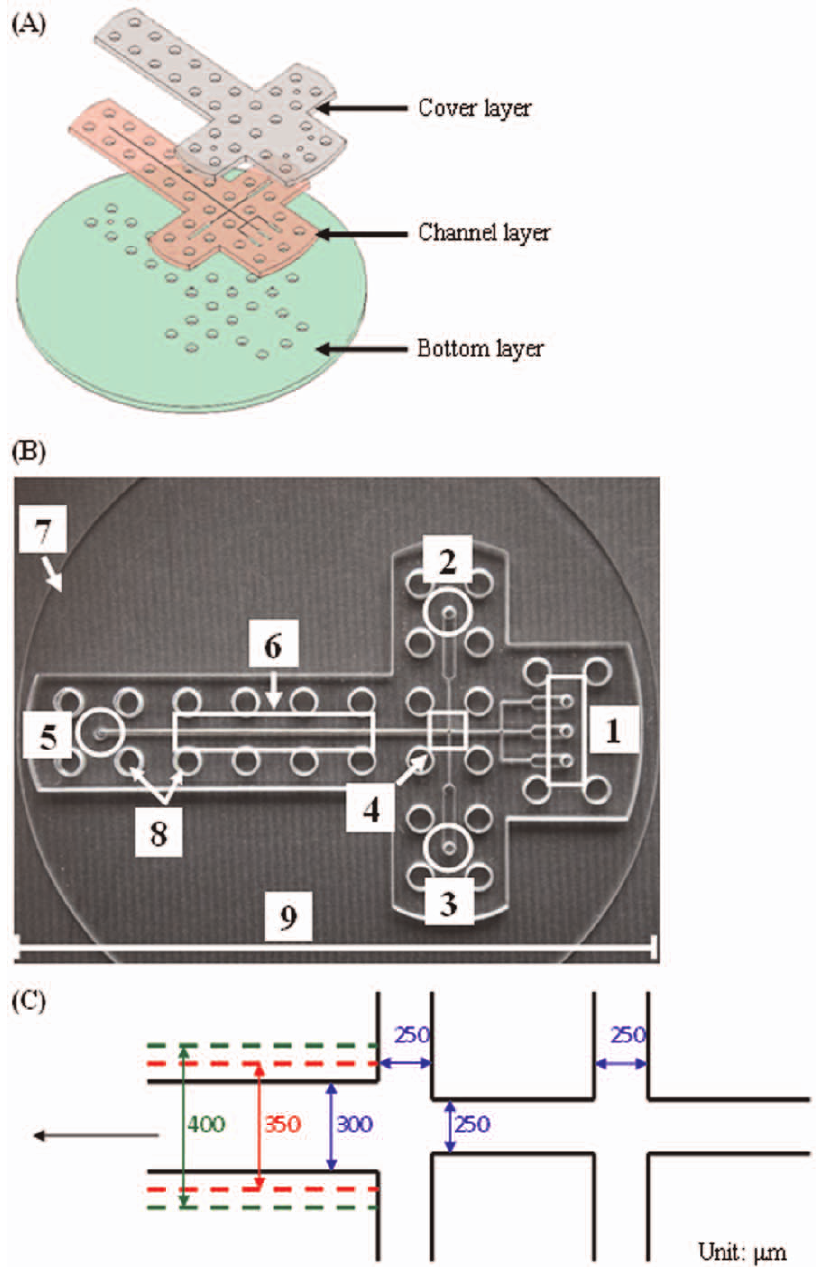
Figure 1. Microfluidic chip. Expanded view (A) and a photo (B) of the microfluidic chip: 1, inlets of center channels; 2 and 3, inlets of side channels; 4, cross junction; 5, outlet; 6, observation channel; 7, bottom layer disk; 8, screw orifices; 9, the scale bar=11 cm. (C) is the geometry of the microfluidic channels.